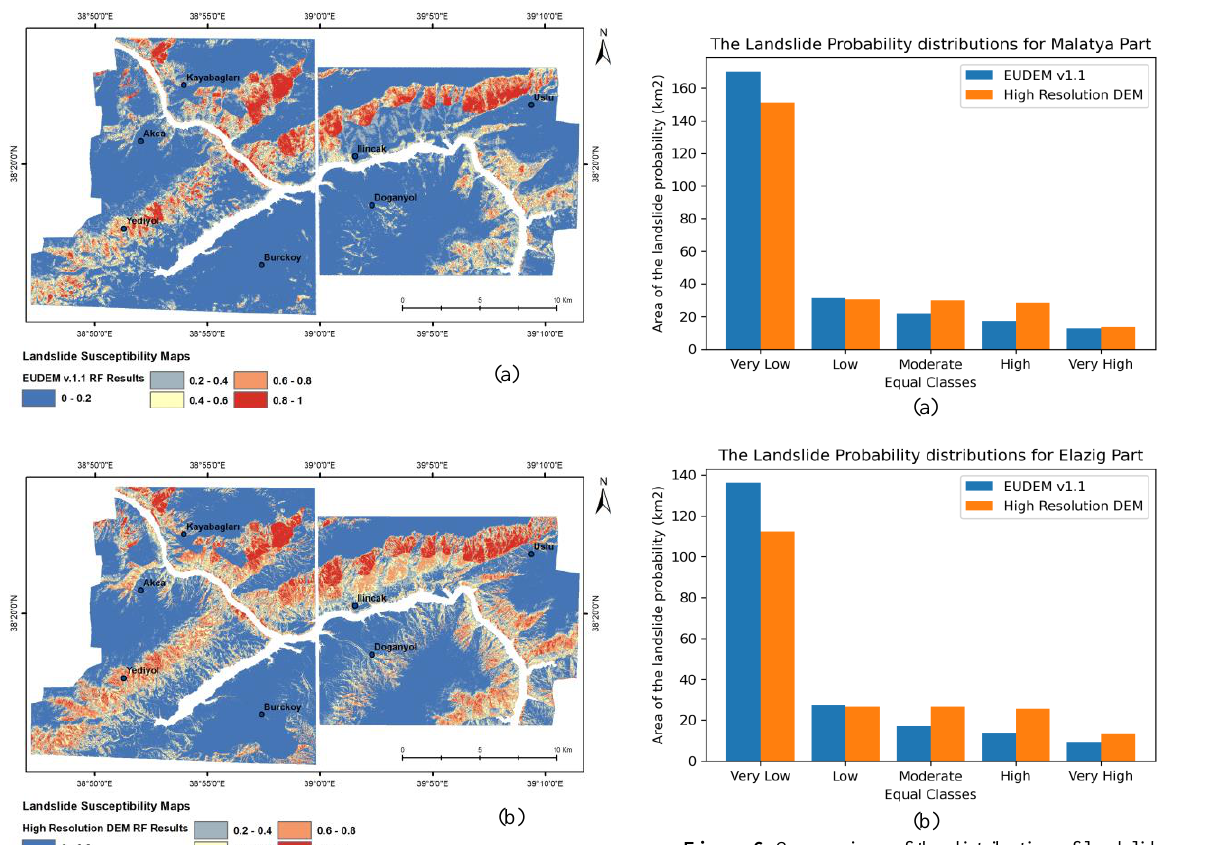
Figure 6 . Comparison of the distribution of landslide probabilities for each class as area